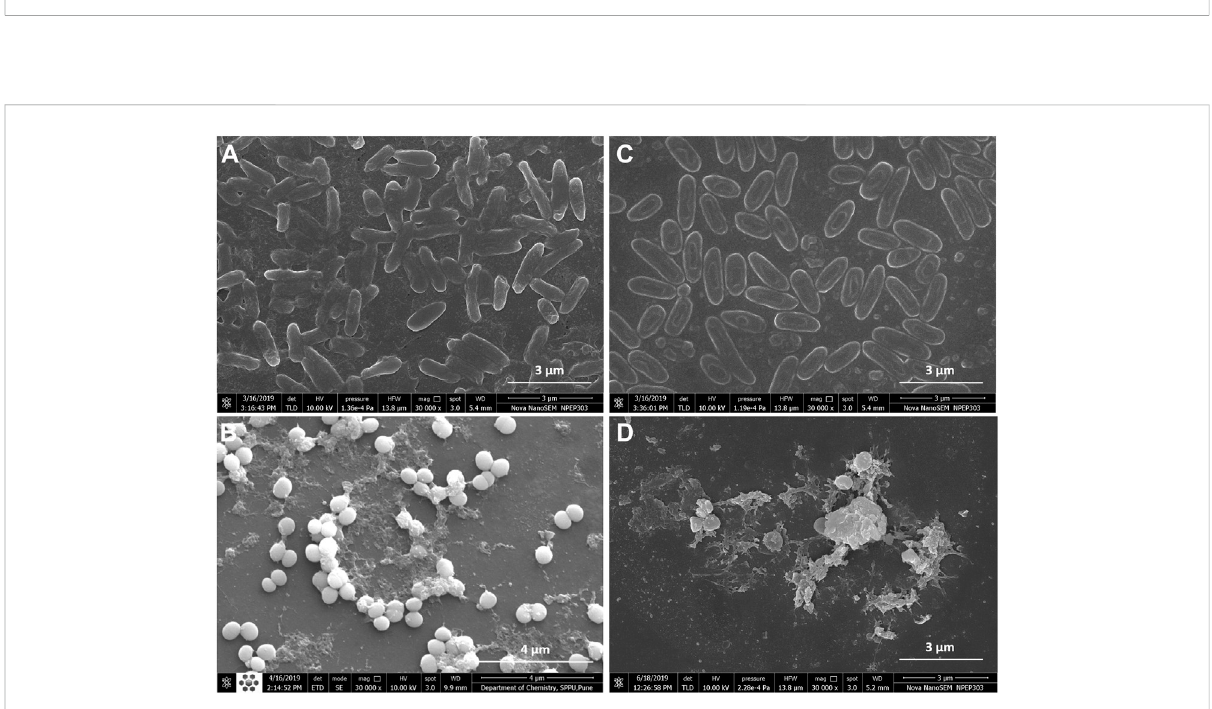
FIGURE 7 FESEM images of 24 h pre-formed bio fi lms at 30,000 × magni fi cation. Untreated bio fi lms of (A) P. aeruginosa PAW1 and (B) S. aureus S8; CAAgNPs treated bio fi lms of (C) P. aeruginosa PAW1 and (D) S. aureus S8. Disruption of extracellular matrix and cell morphology was observed in treated bio fi lms at respective